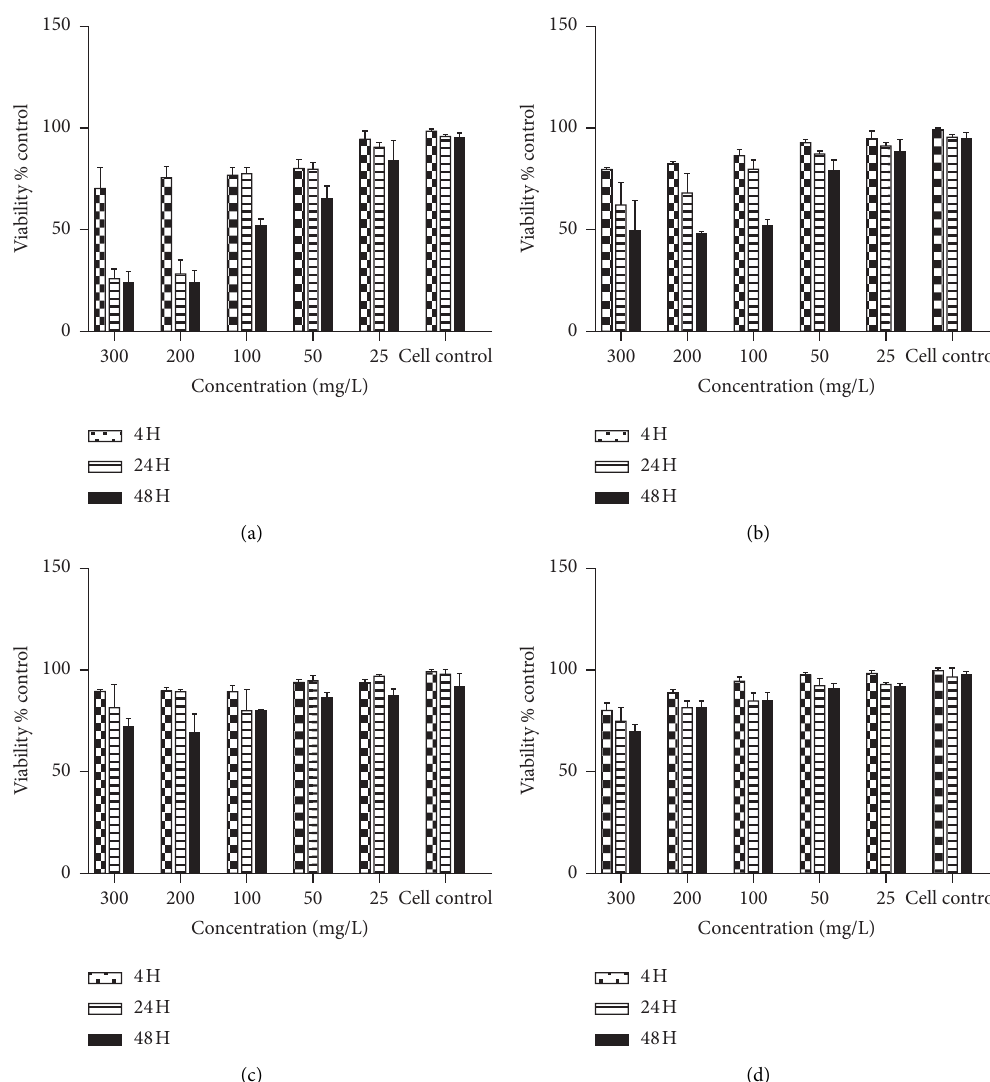
Figure 8: MTTassay to test the effect of AgNPs on the viability of mononuclear cells (MNC). The MNC cells were treated with AgNPs at a concentration of 25, 50, 100, 200, and 300mg/L for 4, 24, and 48h. At the end of the incubation period, mitochondrial function was determined by the MTTreduction assay as described in Materials and Methods. The MNC treated with (a) S-AgNPs-1, (b) G-AgNPs-1, (c) S-AgNPs 2 , and (d) G-AgNPs-2. The values represent the mean standard deviation of three experiments; to compare the mean values between the control and treatment groups, Student’s t -test was applied ( p < 0 . 05 for